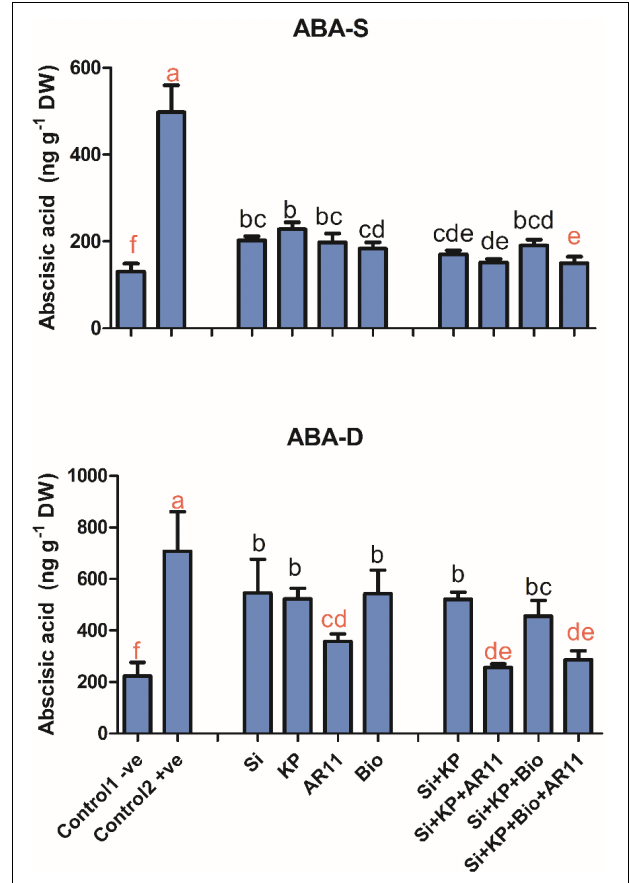
FIGURE 6 | Effect of co-application (AR11, Si, K 2 HPO 4 , and biochar) on the abscisic acid (ABA) level under salt and drought stresses. (-S), salt; (-D), drought. Error bars represent standard deviations. Each data point represents the mean of at least three replications. Bars with different letters are significantly different from each other at P ≤